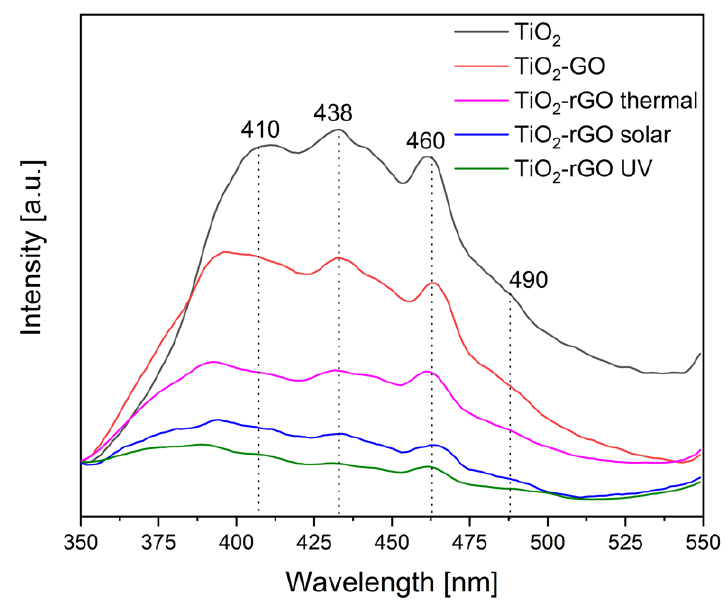
Figure 2. Photoluminescence spectra with λ exc = 300 nm.